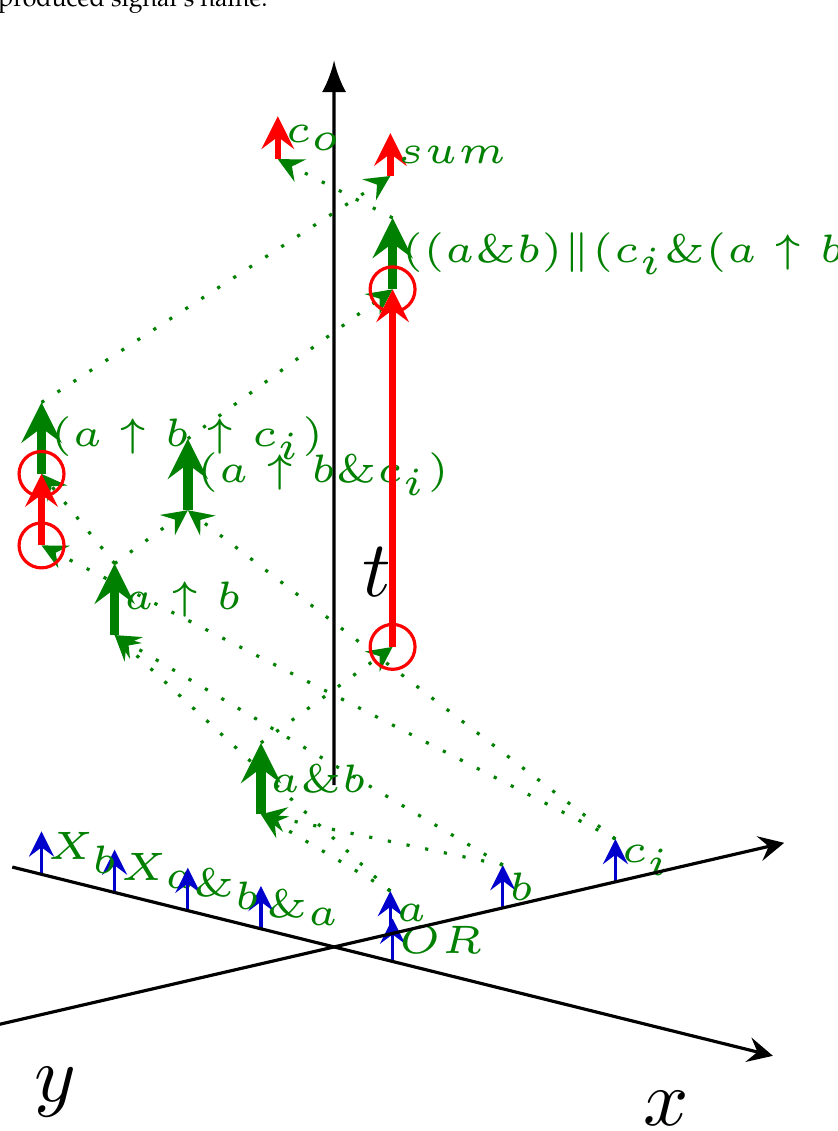
gate (dotted green arrows), which (after its operating time passes) produces the output signal, starting immediately towards the next gate. The vertical green arrows denote gate processing (one can project the arrow to axis x to find out the gate’s ID), labeled with the produced signal’s name.